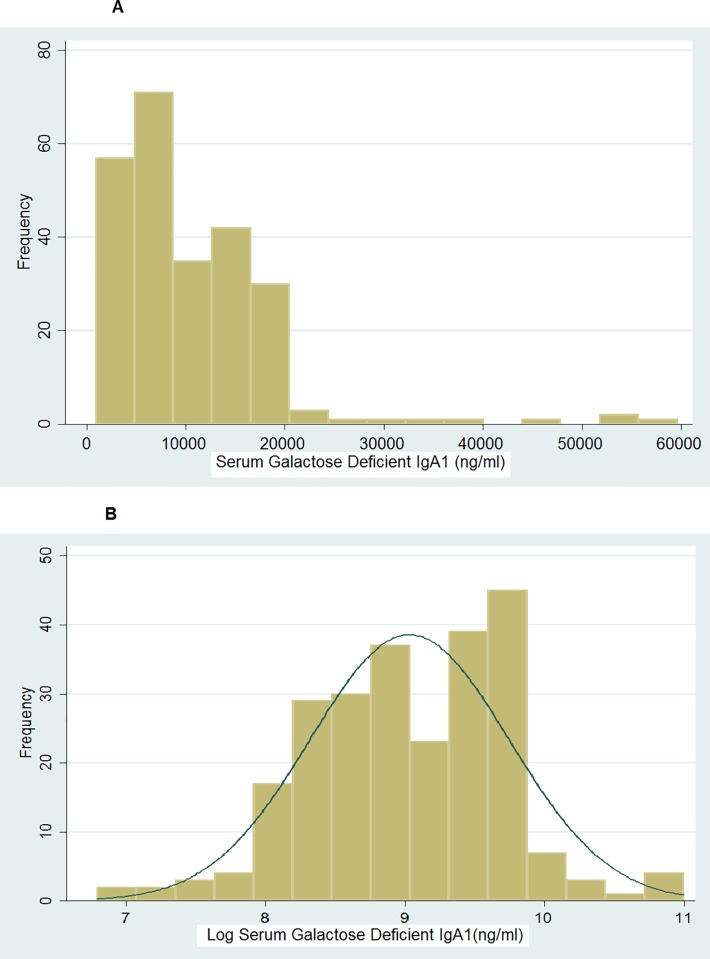
Histogram showing distribution of values of serum galactose deficient IgA1(ng/ml) before(4A) and after(4B) logarithmic transformation.